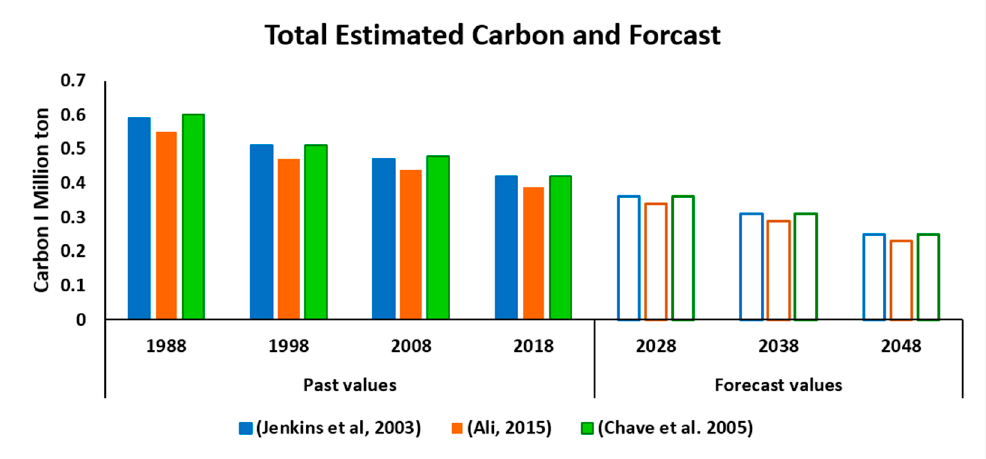
Figure 6. Total forest carbon in million tons using the equations of Jenkin et al. 2003, Ali (2015) and Chave et al., 2005 from 1988 to 2018 and for the future 30 years using linear forecast analysis.